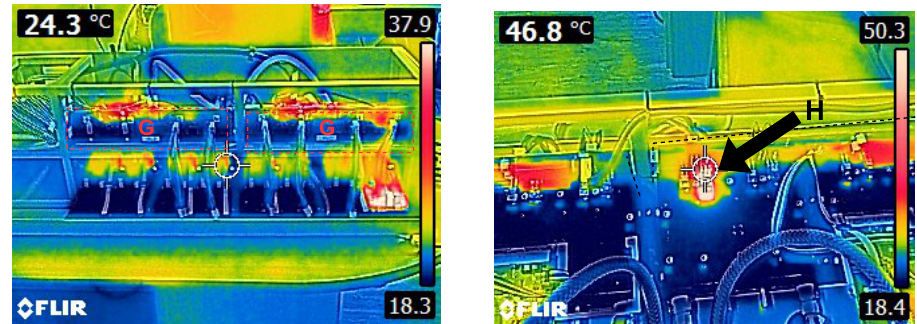
Figure 9. Thermal image of a Burn-in station undertaking burn-in of a Brick ( Left ). Thermal of an operational dummy load board VCC MOSFET affixed to a cooling plate ( Right